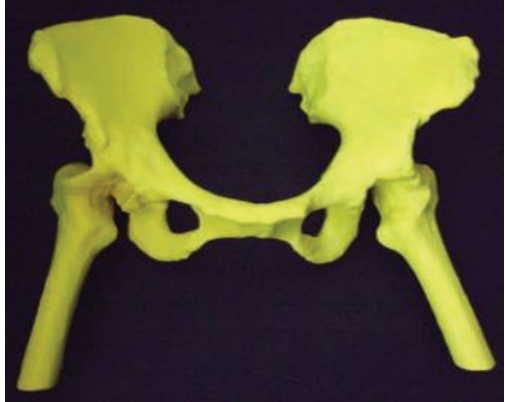
Figure 3. Post FDM Dysplastic Hip Model.